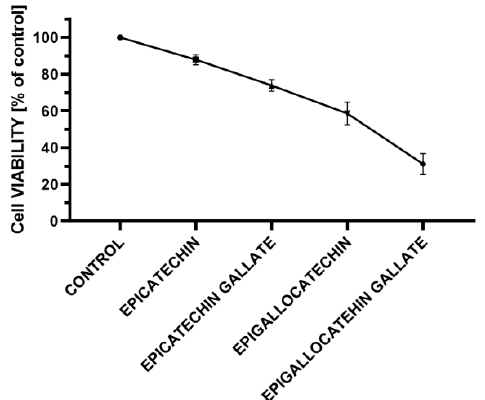
Figure 4. The cellular viability of MCF-7 cells after 24 h incubation according to green tea catechin’s concentration (mean ± SD, n = 3).